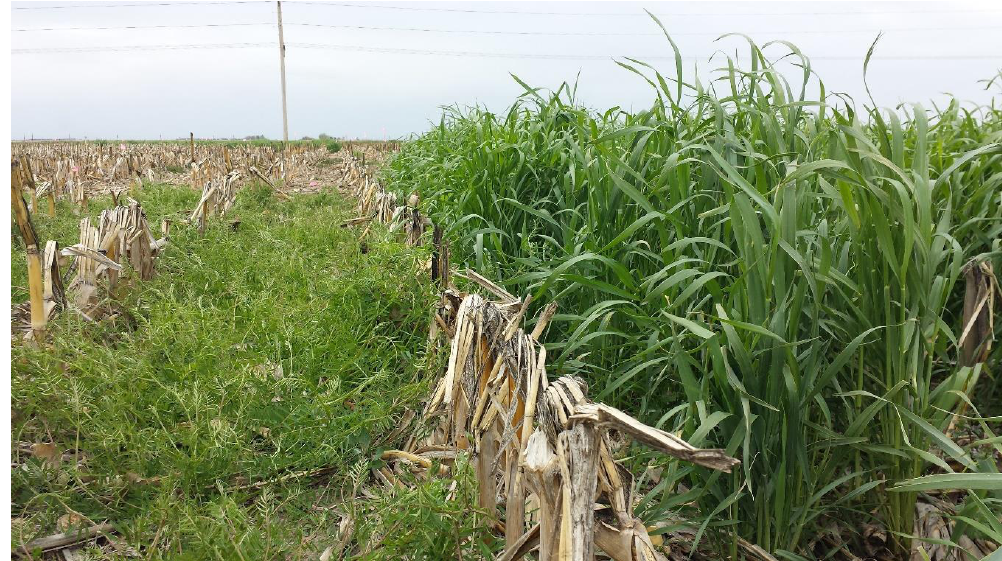
Figure 5. Vetch (left) and rye (right) on 4 May 2017 at Clay Center. Cover crops were broadcast into corn 20 September 2016.